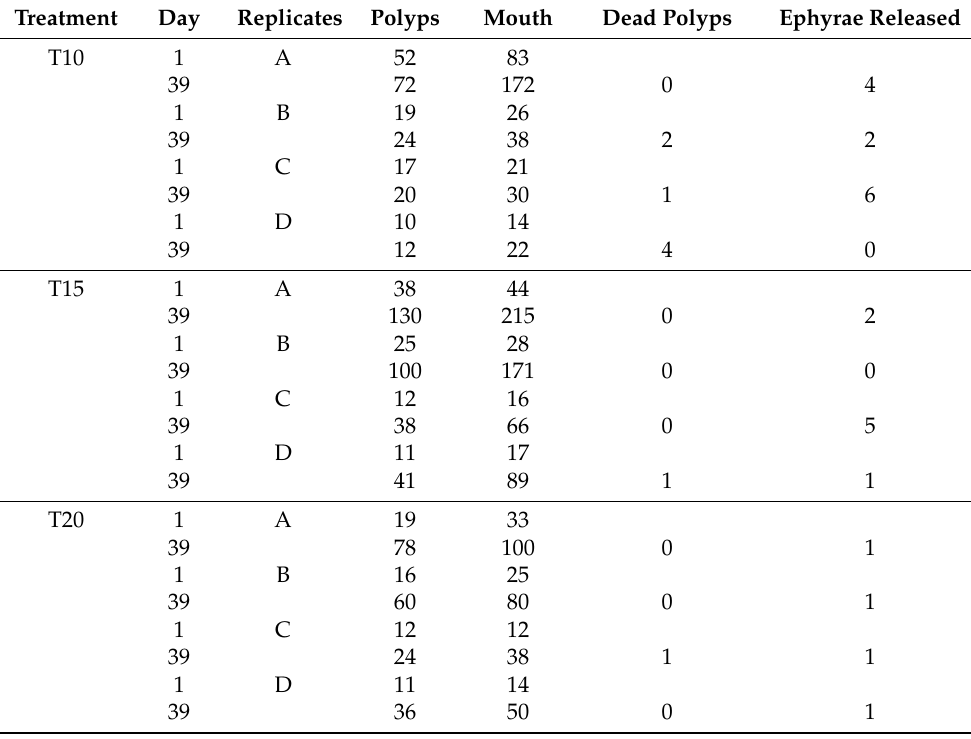
Table 1. Number of polyps, mouths, dead polyps and released ephyrae counted at the beginning and at the end of incubation at 10, 15 and 20 ◦ C.